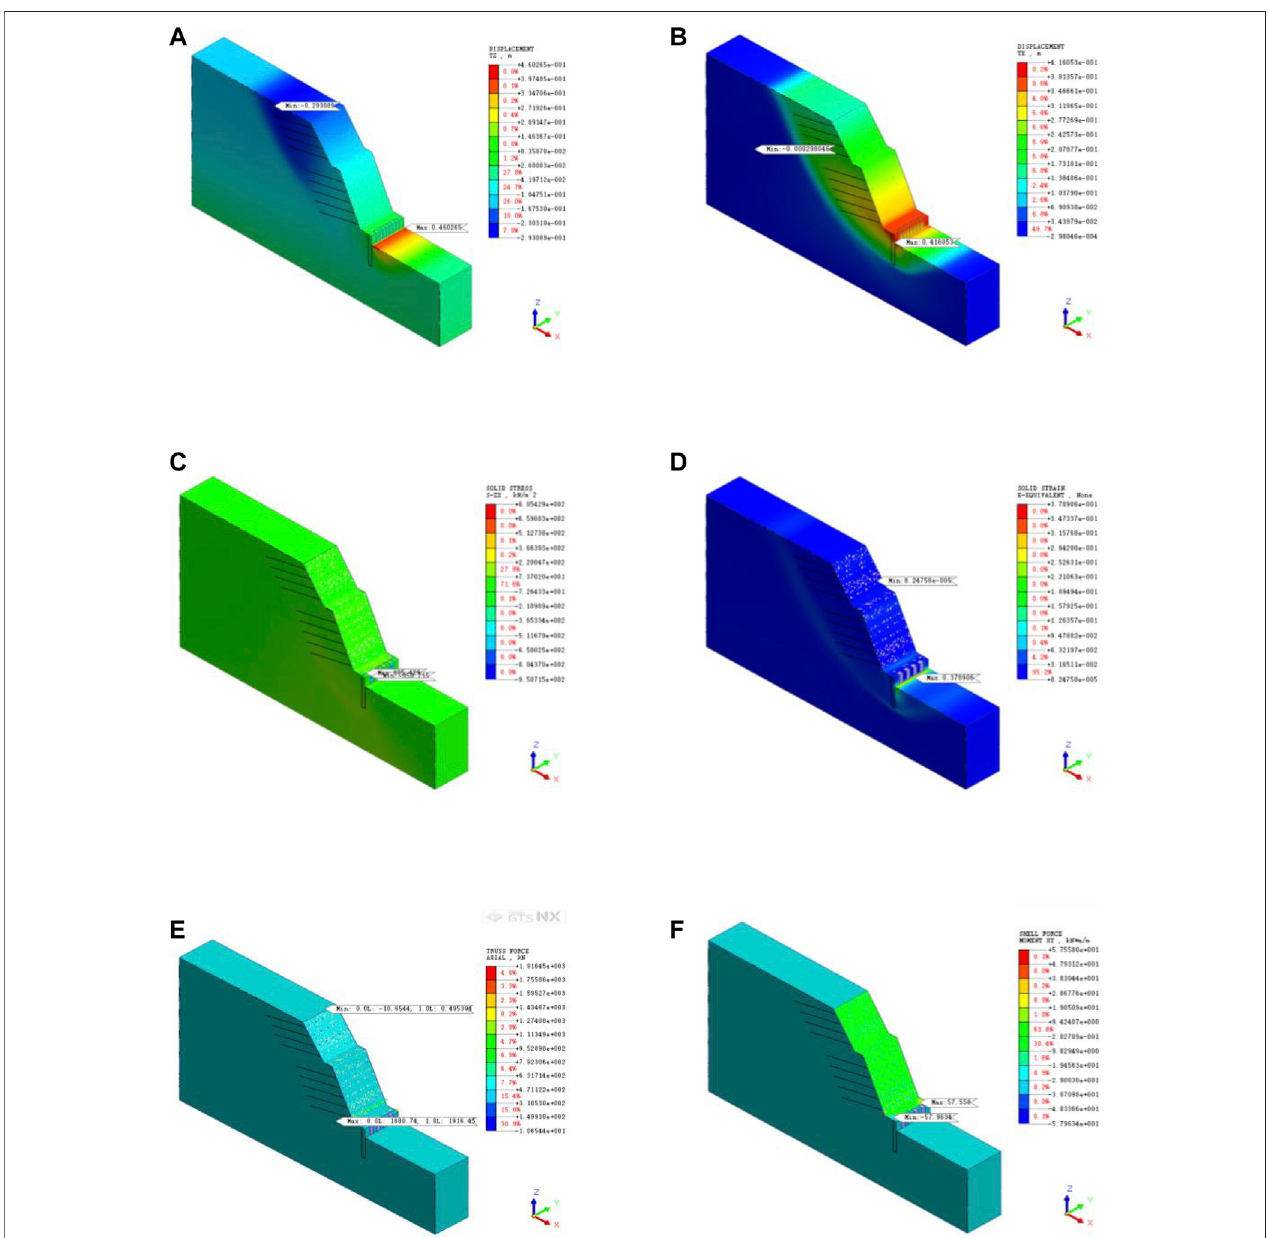
FIGURE 14 | Calculation results after construction of supporting structure of rock-slag and sand slope: (A) vertical displacement diagram of rock-slag and sand slope after construct support; (B) horizontal displacement diagram of rock-slag and sand slope after construct support; (C) axial diagram of anchor bolt after construct support of rock-slag and sand slope; (D) plastic strain diagram of rock-slag and sand slope after construct support; (E) axial diagram of anchor bolt after construct support of rock-slag and sand slope; (F) bending moment diagram of shotcrete on a slope.